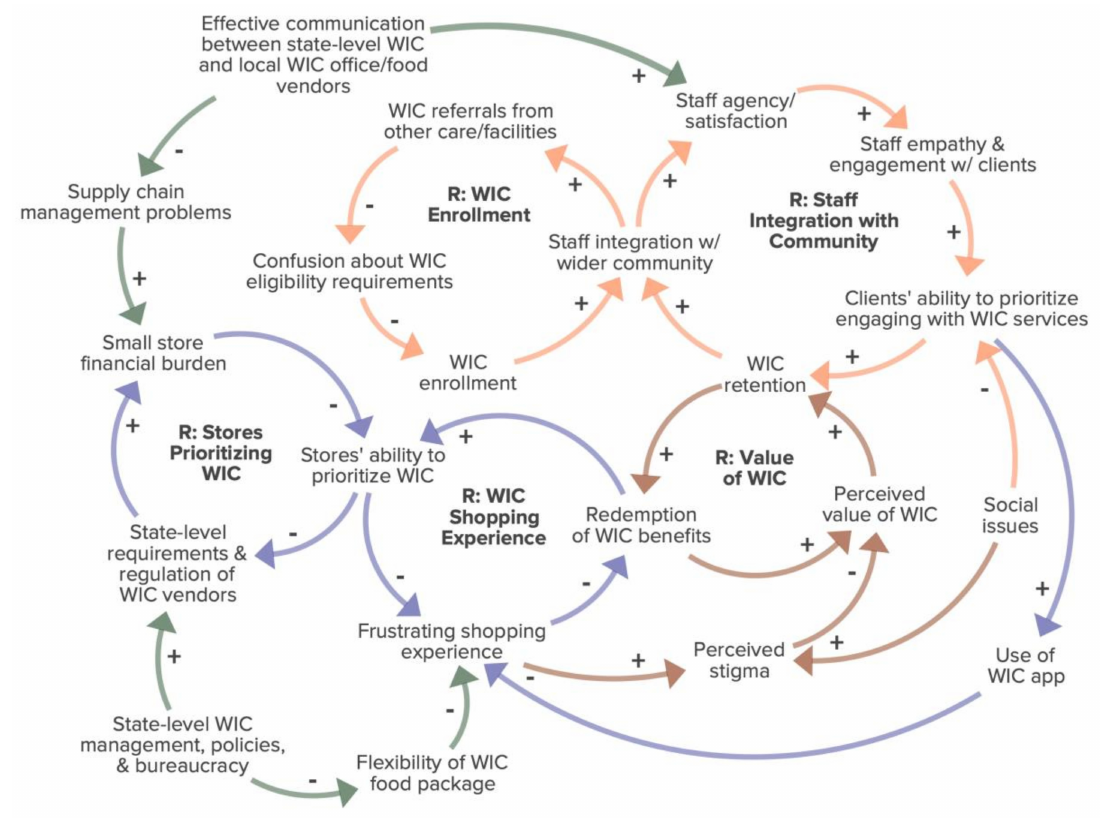
Figure 2. Causal loop diagram of factors influencing participation in the KBIC WIC program. R: Reinforcing Loop; green arrow: State-level Administration and Bureaucracy theme; purple arrow: Reservation and Food Store Infrastructure theme; orange arrow: WIC Staff Interactions and Integra- tion with the Community theme; brown arrow: Perceived Value of WIC theme. +: connected factors change in the same direction; − : connected factors change in opposite